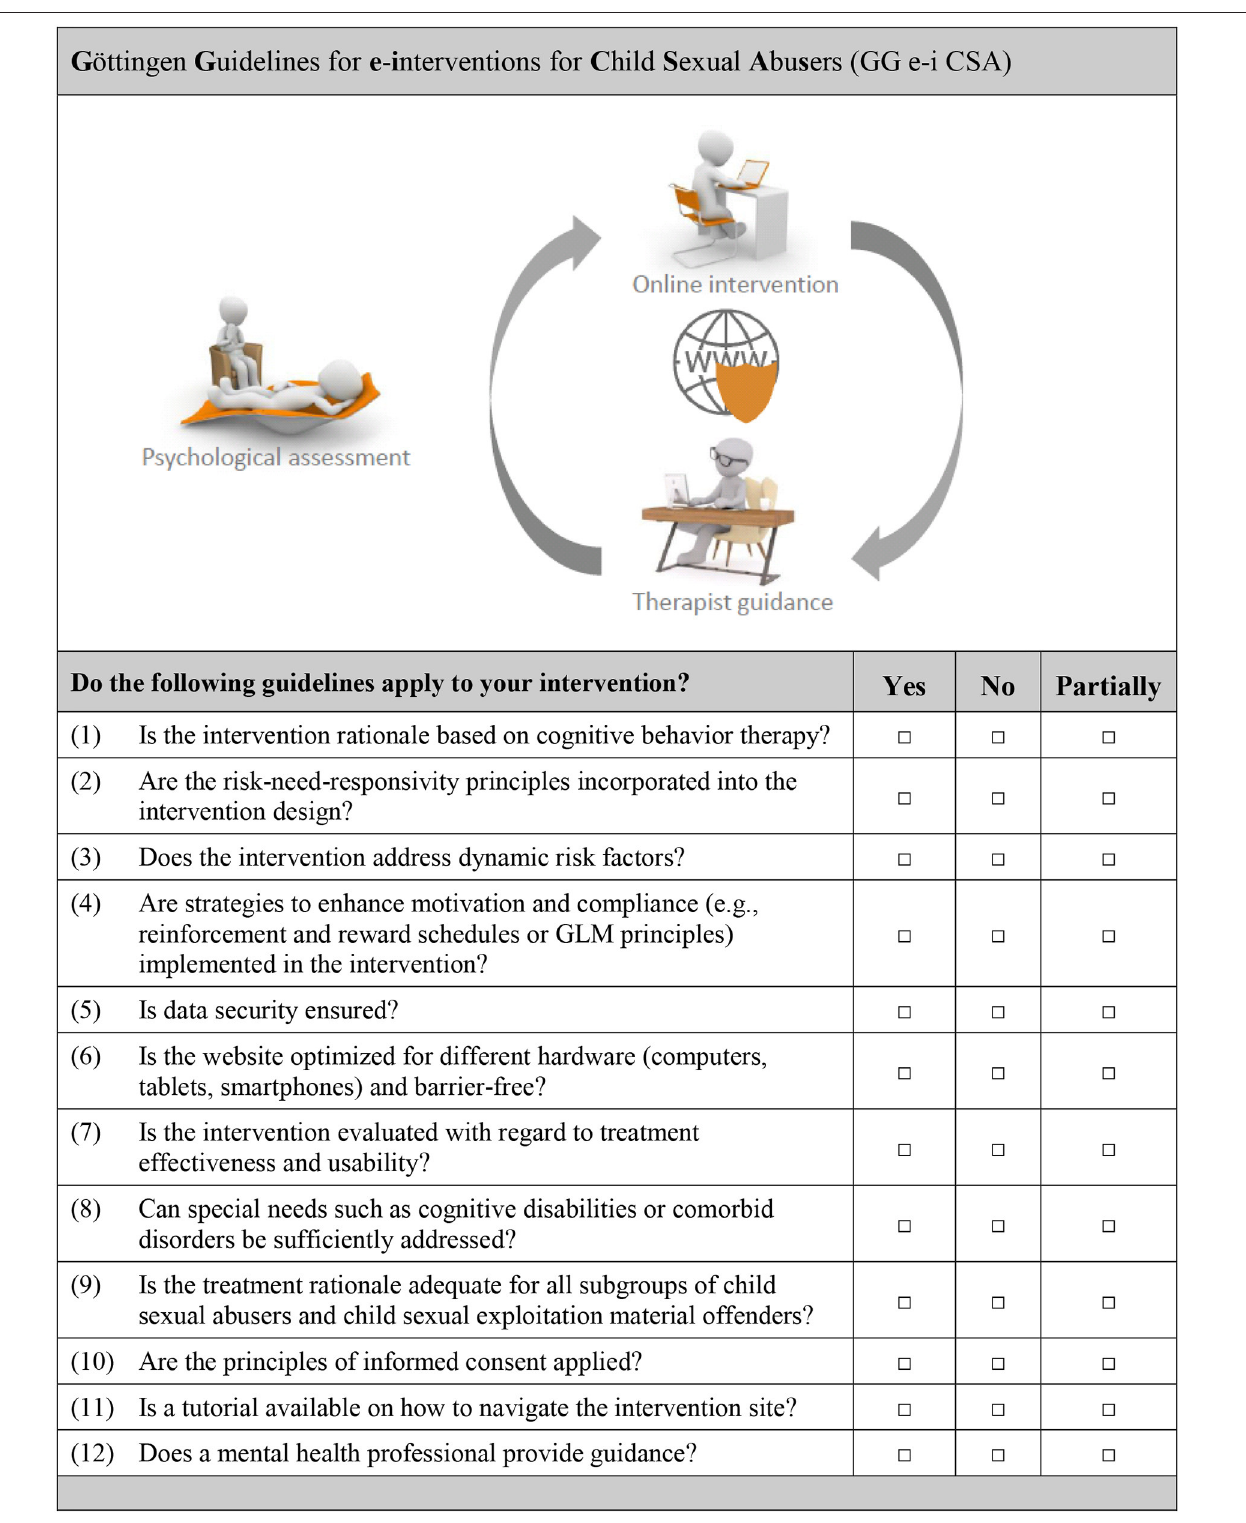
Frontiers in Psychiatry |